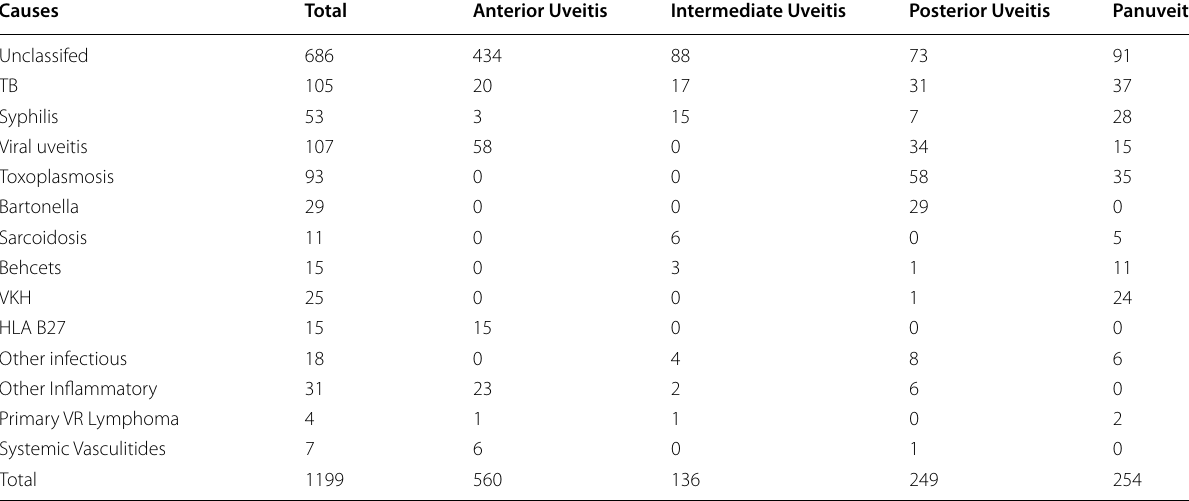
Table 2 Causative Pattern of New Diagnosed Uveitis according to SUN classification